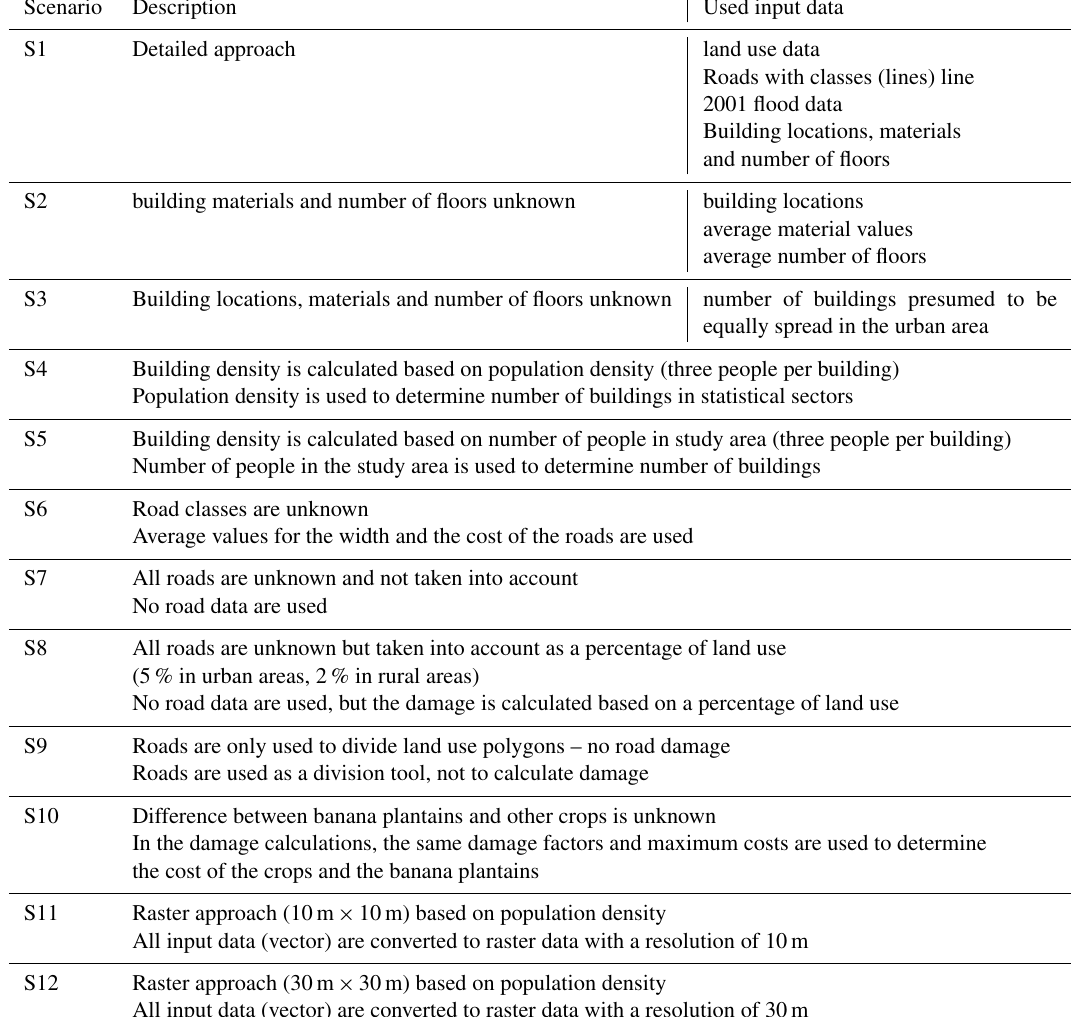
Table 2. Overview of investigated scenarios in the sensitivity